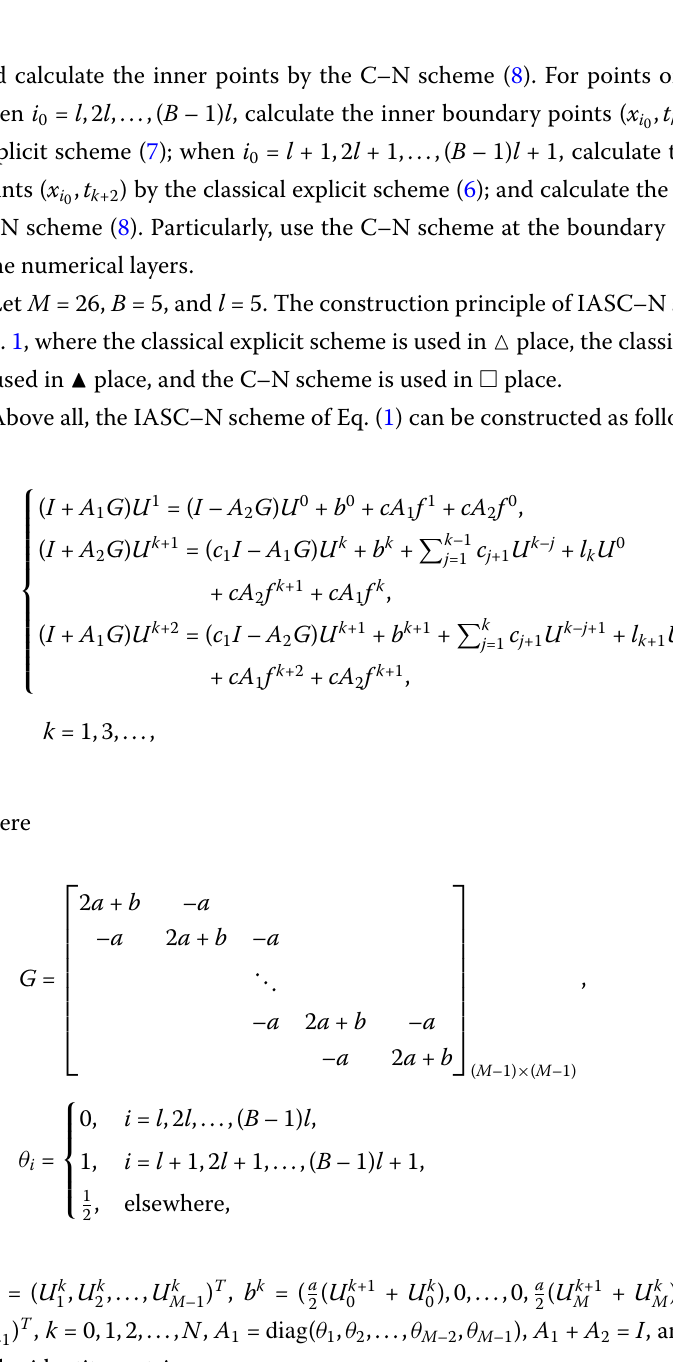
, t k +2 ) by the classical 0